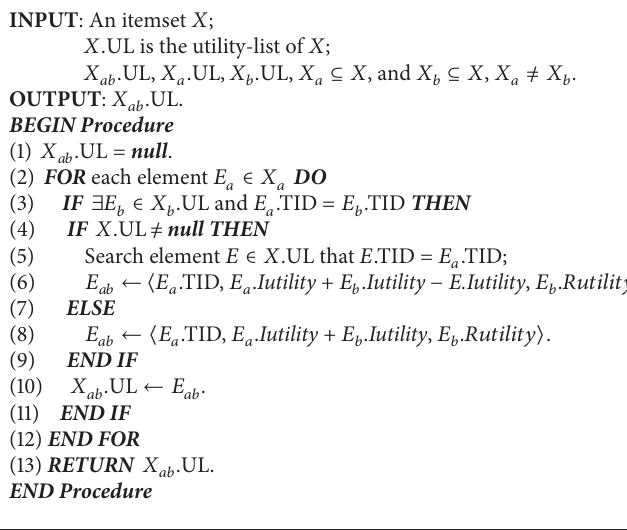
Algorithm 1: Pseudocode of utility-list structures construction algorithm.